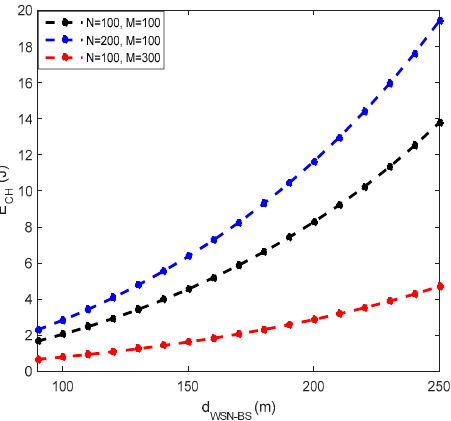
Figure 7. Consumption of the CH node as a function of WSN–BS station distance.